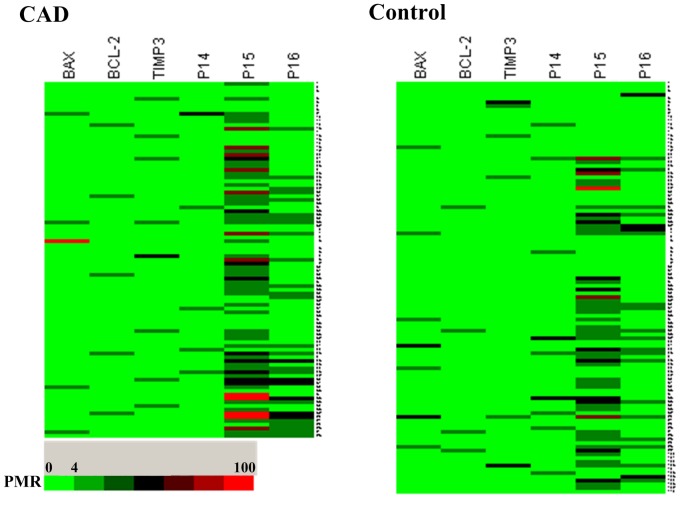
Heatmap for the CAD patients and controls.Six candidate loci are termed at the top. Details of MethyLight assay and PMR definition are delineated in the Methods section. The colored squares indicate the same range in PMR values as defined in the colorbar. DNA methylation levels are indicated by a color gradient, with the highest DNA methylation levels for each locus indicated in red and the lowest in deep green. The unmethylated loci (PMR<4) are indicated in green.